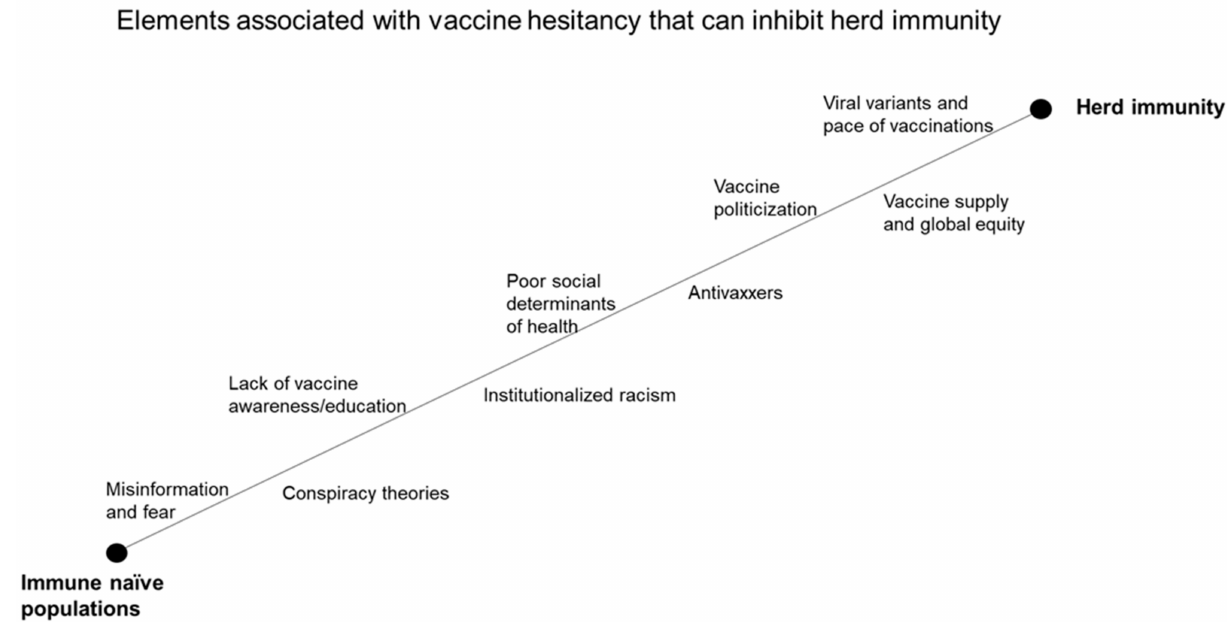
Figure 1. Elements of COVID-19 vaccine hesitancy that can impact herd immunity.